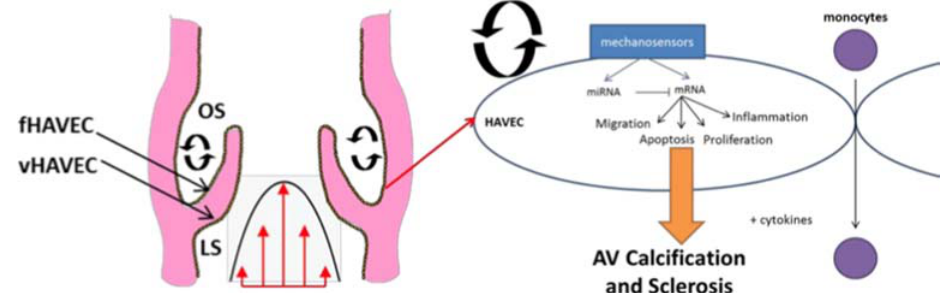
Figure 2. Illustration of difference in the hemodynamic environment for the fibrosa side versus the ventricularis side of the aortic heart valve and the influence on calcification and